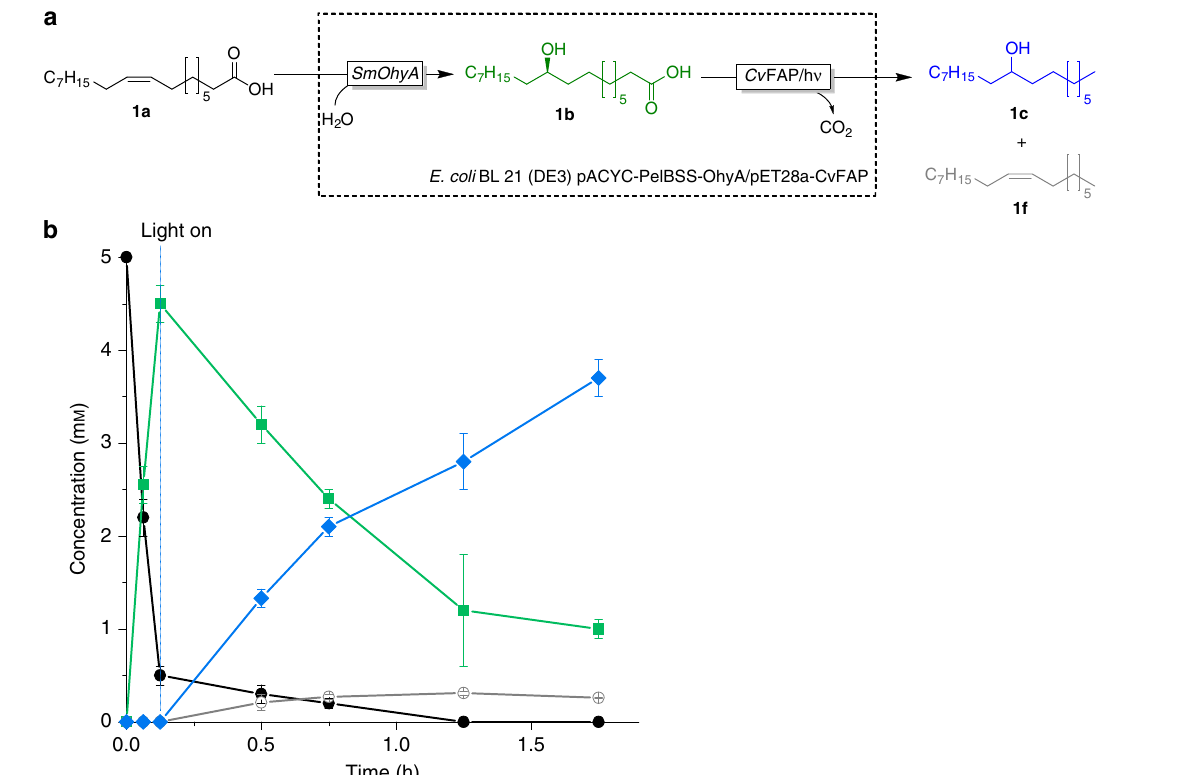
Fig. 6 Photoenzymatic cascade. a Reaction scheme of the photoenzymatic cascade combining Sm OhA and Cv FAP in a single expression host. b Time course of the conversion of oleic acid using co-expressed enzymes. Oleic acid ( 1a , black circles) was converted via 10-hydroxystearic acid ( 1b , green squares) into 9-heptadecanol ( 1c , blue diamonds) and the side-product (Z) -heptadec-8-ene ( 1f , grey empty circles) using the freshly designed, all-inclusive E. coli BL21 (DE3) pACYC-PelBSS-OhyA/pET28a-C v FAP. [oleic acid] = 5 mM, [ E. coli co-expressing Sm OhyA and Cv FAP] = 7 g dry cells L − 1 , Tris-HCl buffer pH 6.5 (50 mM), illumination with blue light ( λ = 450 nm; intensity = 13.7 mE L − 1 s − 1 ). For the reaction, fi rst the Sm OhyA-catalysed hydration reaction was performed for 0.125 h followed by Cv FAP-catalysed decarboxylation under illumination for another 1.625 h. Values represent the average of duplicates ( n = 2). Error bars indicate the standard deviation.